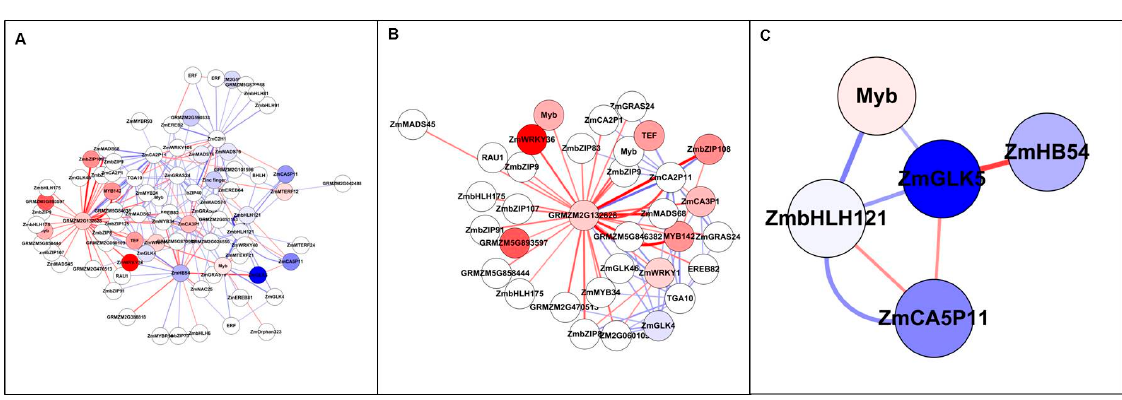
Figure 6. Top 200 interactions from TFs by ANN analysis (Study 1). All nodes are coloured based on fold change value (FC > 2): blue represents down-regulated, while red represents up-regulated. Edge with red colour indicates a positive interaction (stimulation), while edge with blue colour indicates a negative interaction (inhibition). The edge thickness based on Z -score value. ( A ) All TFs network with Top 200 interactions. Eighty-one TFs included 11 up-regulated and 13 down-regulated TFs. ( B ) Extracted subnetwork with GRMZM2G132628 as core hub surrounded with 30 positive interactions. ( C ) Extracted subnetwork with ZmGLK5 connected with four differentially expressed genes: ZmHB54, ZmbHLH121 and two TFs (GRMZM5G825312 and GRMZM5G868618).